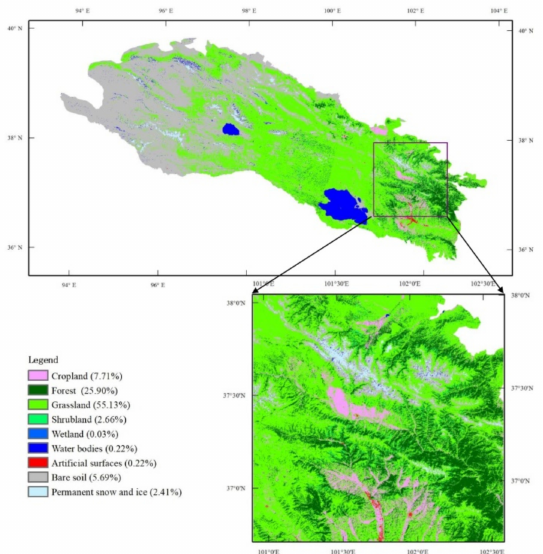
Figure 1. Land cover map of the Qilian Mountain range region and study area: the proportions of each land cover type in the study area are shown in the